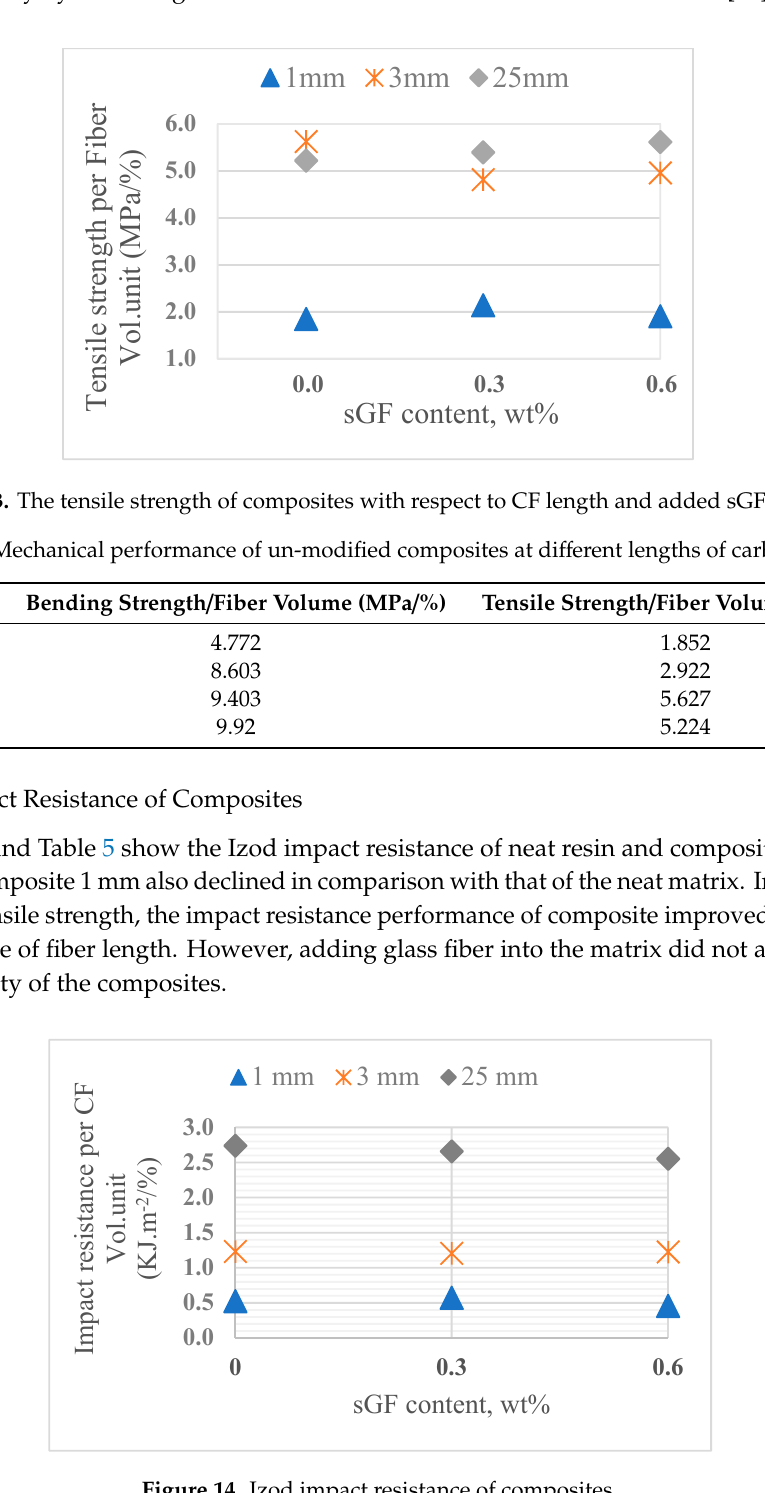
Figure 14. Izod impact resistance of composites. Table 5. The Izod impact resistance of composites and neat resin.